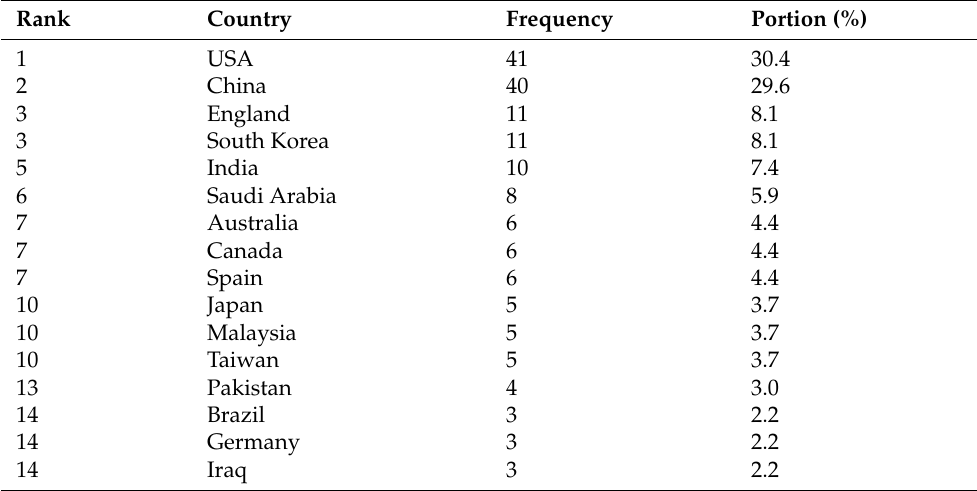
Table A1. Distribution of articles by country of